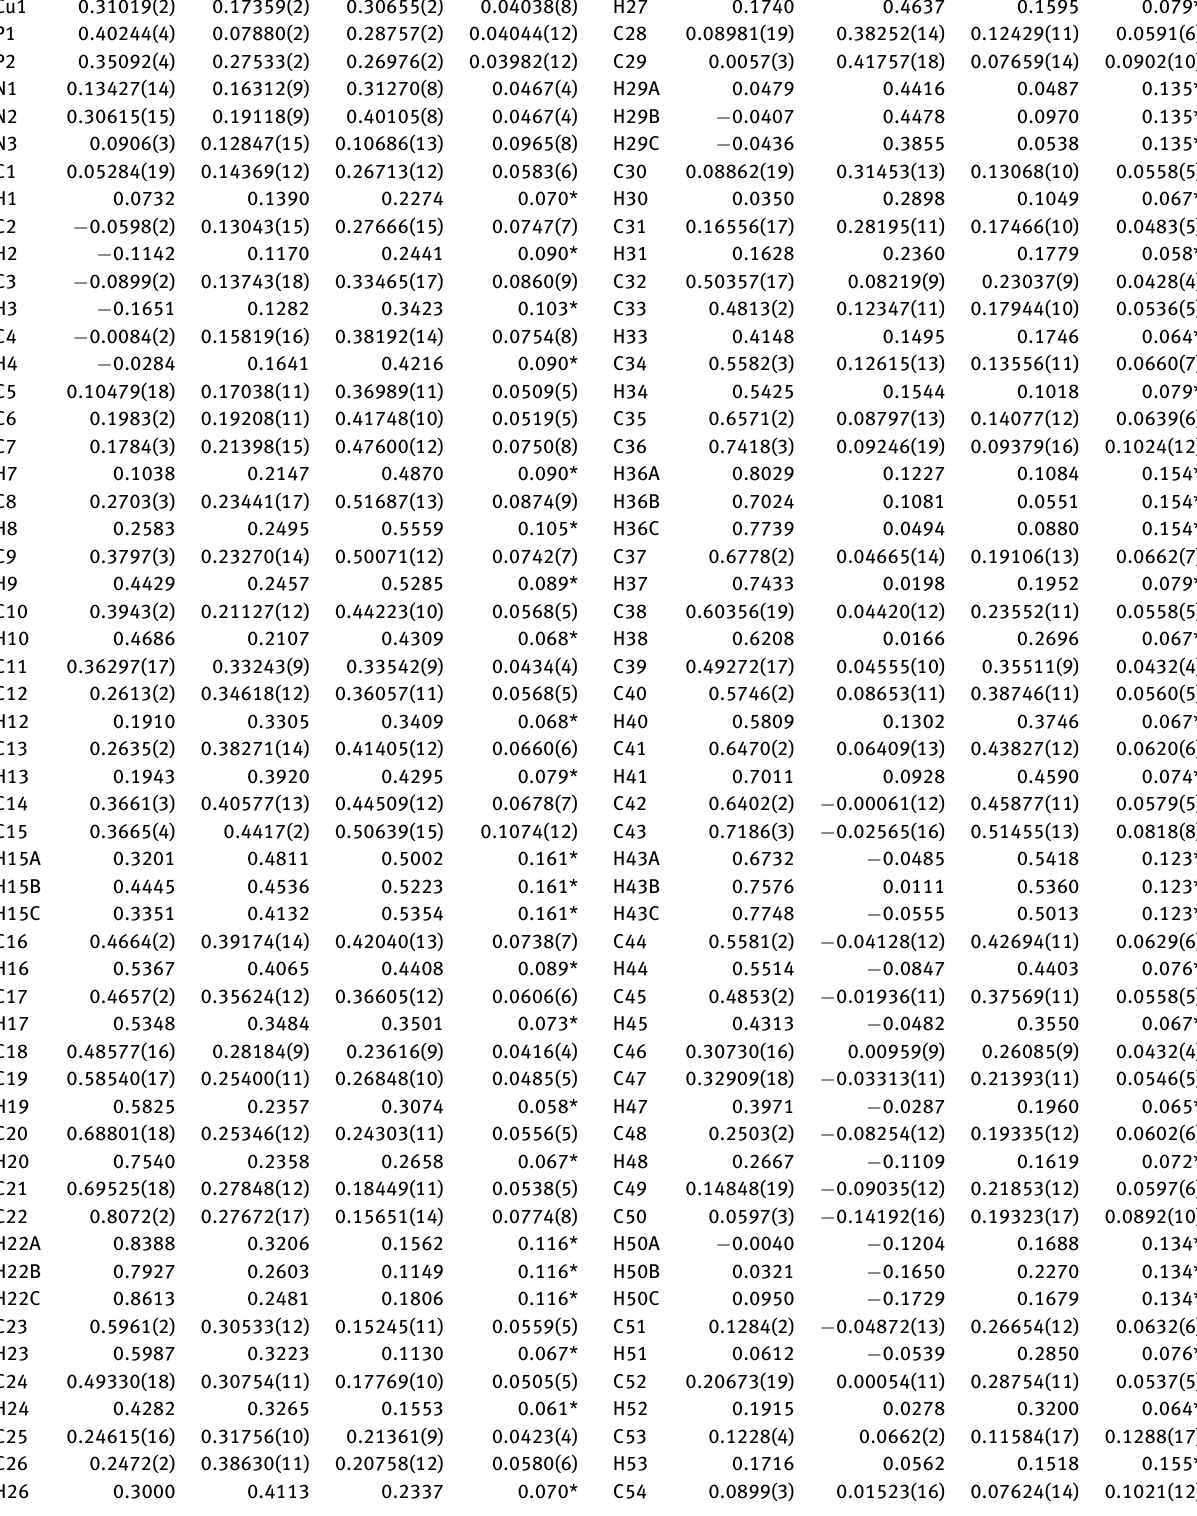
Table 2: Fractional atomic coordinates and isotropic or equivalent isotropic displacement parameters (Å 2